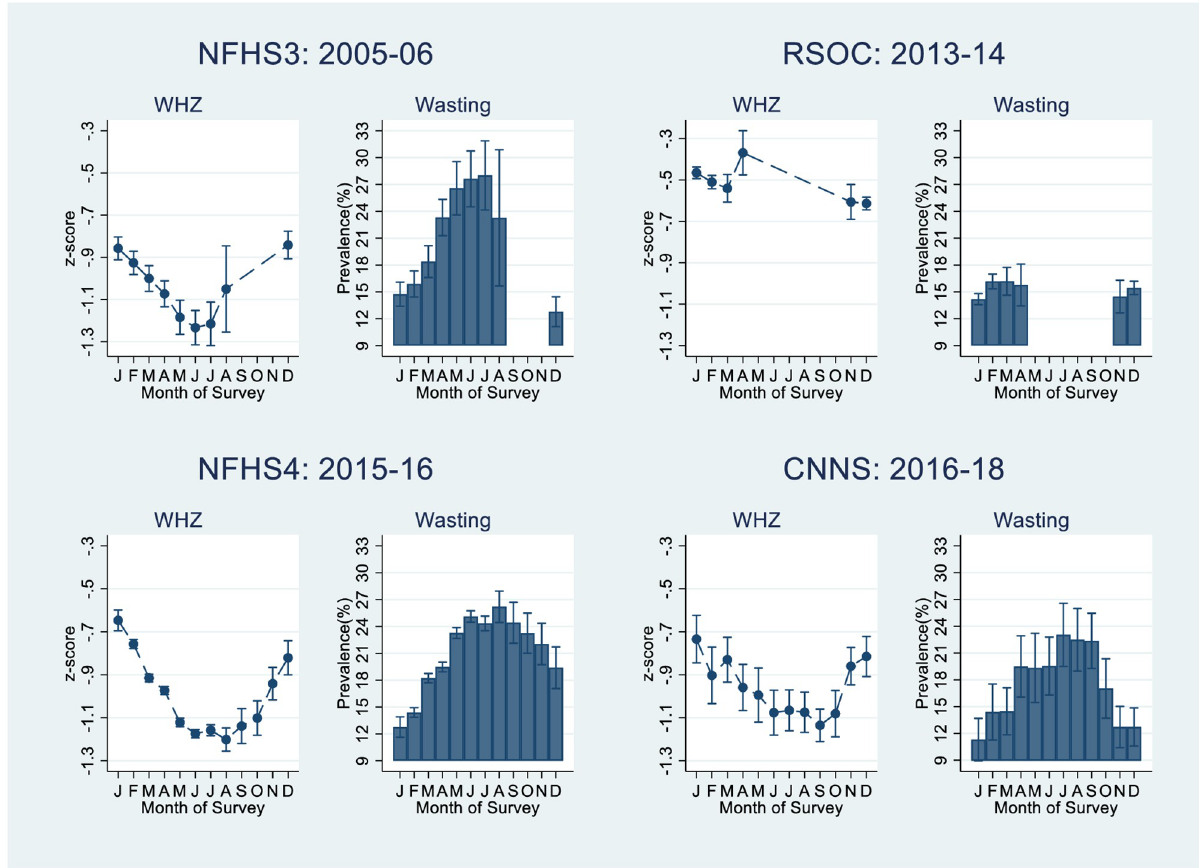
Fig 3. Estimated adjusted mean WHZ and prevalence of wasting presented by month of survey from NFHS-3, RSOC, NFHS-4 and CNNS.